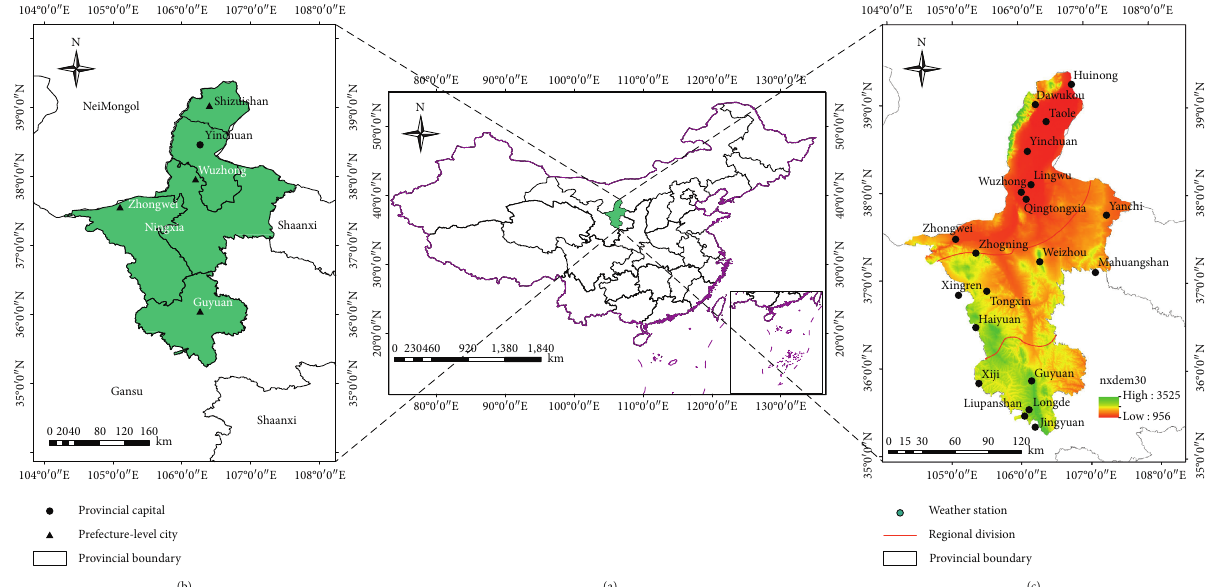
Figure 2: Location and administrative division of the study area: (a) a map of China with the study area shown in green; (b) a political map of the Ningxia Hui Autonomous Region with the location of the urban center; (c) a topographical map of the Ningxia Hui Autonomous Region with the distribution of the climate stations in the study area and climate stations are marked by solid black